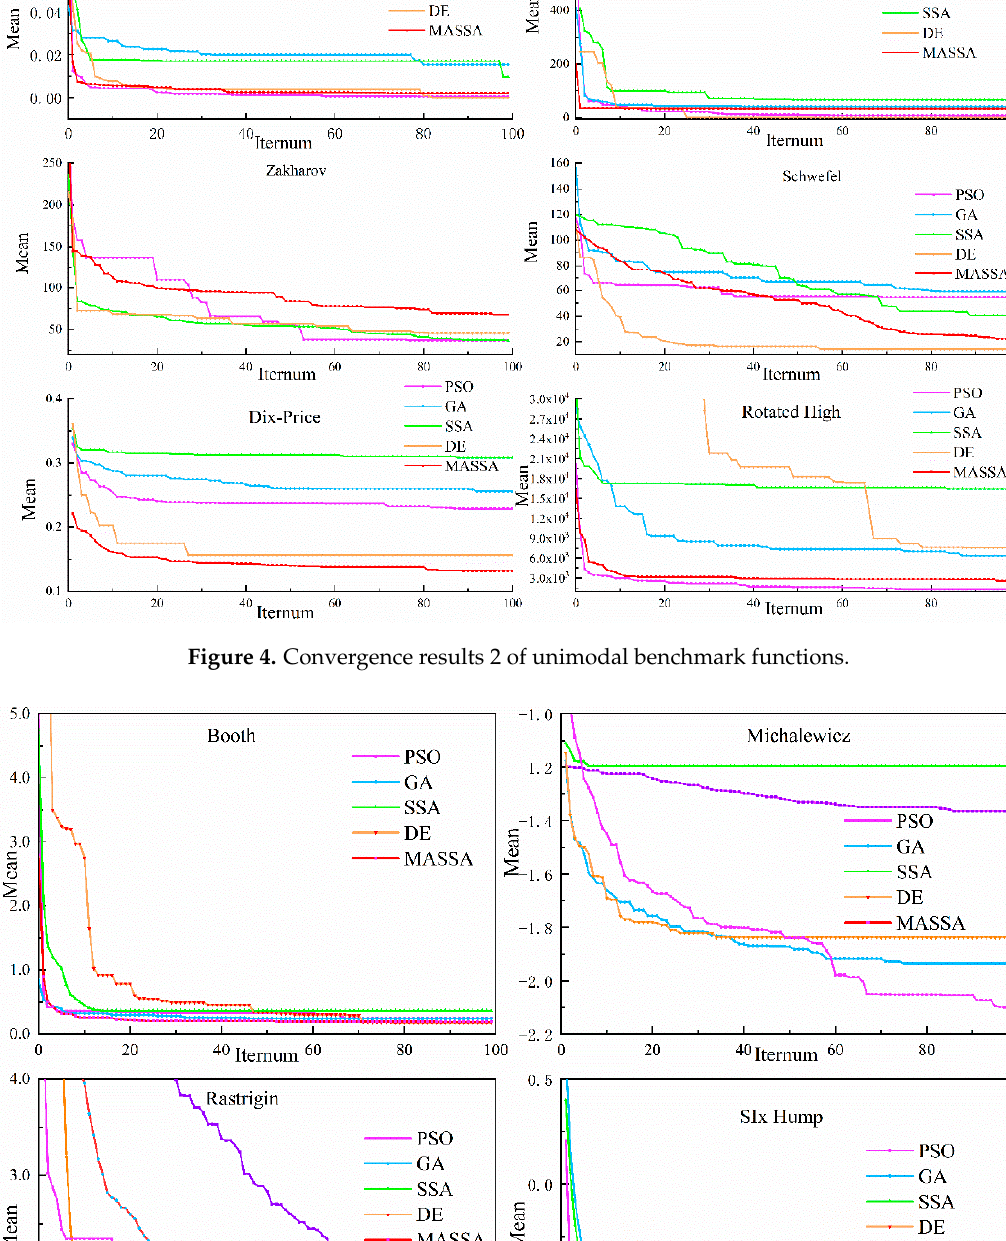
Figure 6. Convergence results 2 of multimodal benchmark functions.